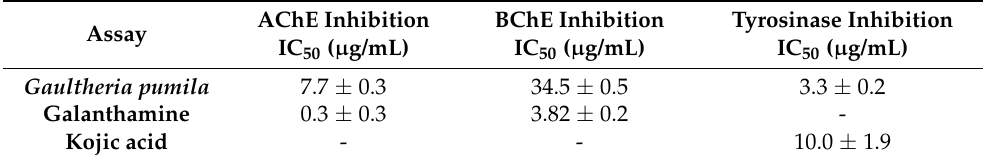
Table 3. Enzymatic inhibitory activity of Gaultheria pumila